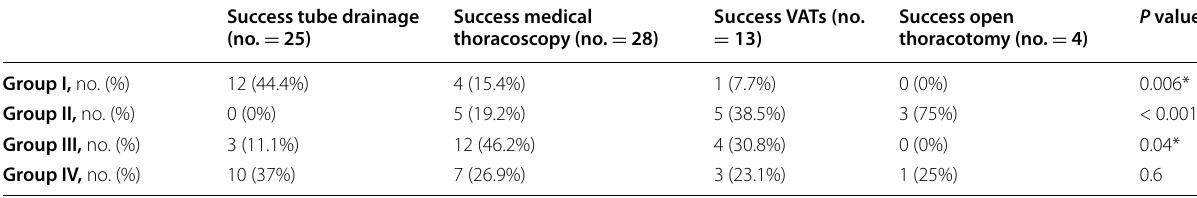
* means significant